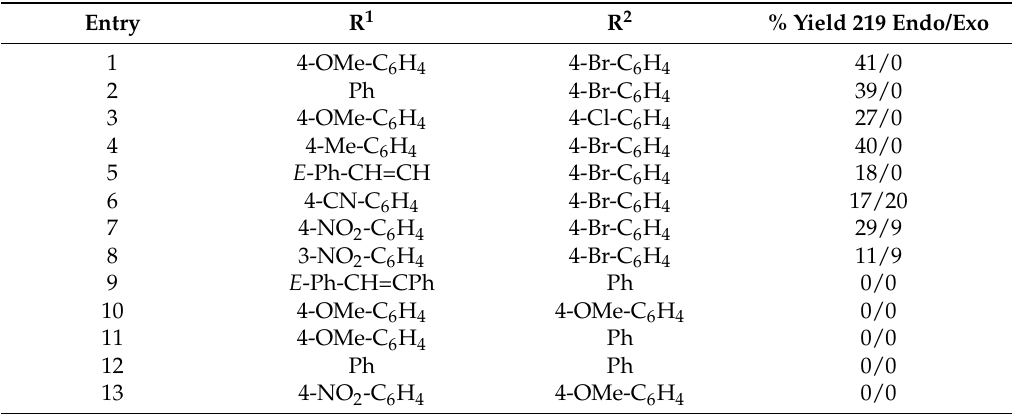
Table 30. Reaction of benzaldehyde-derived imines 210 with difluorocarbene and aldehydes 2 or ketones 3 , yielding oxazolidinones 222 (Scheme 63). Entry